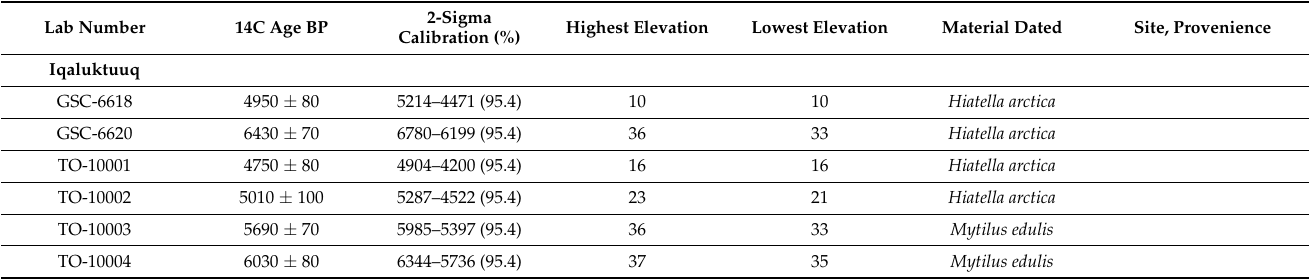
Table 3. Radiocarbon dates used for construction of the sea level curve at Iqaluktuuq and Kent